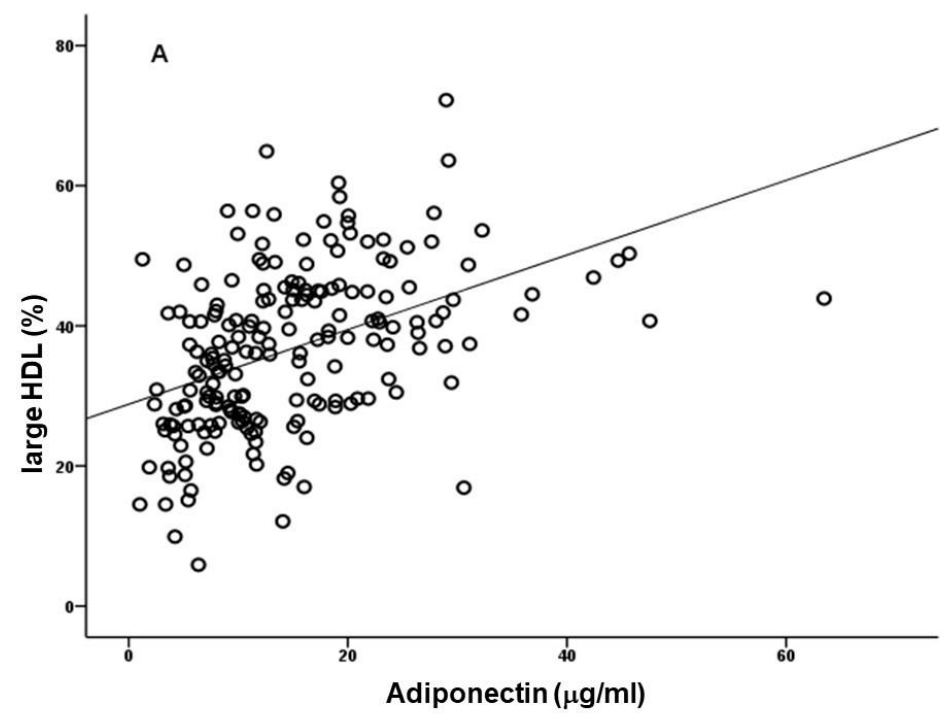
Figure 2. Association of circulating levels of adiponectin with large high-density lipoprotein (HDL), in end-stage renal disease patients under chronic hemodialysis ( r = 0.509, p < 0.001). Adapted from Coimbra et al. 2019 [9].